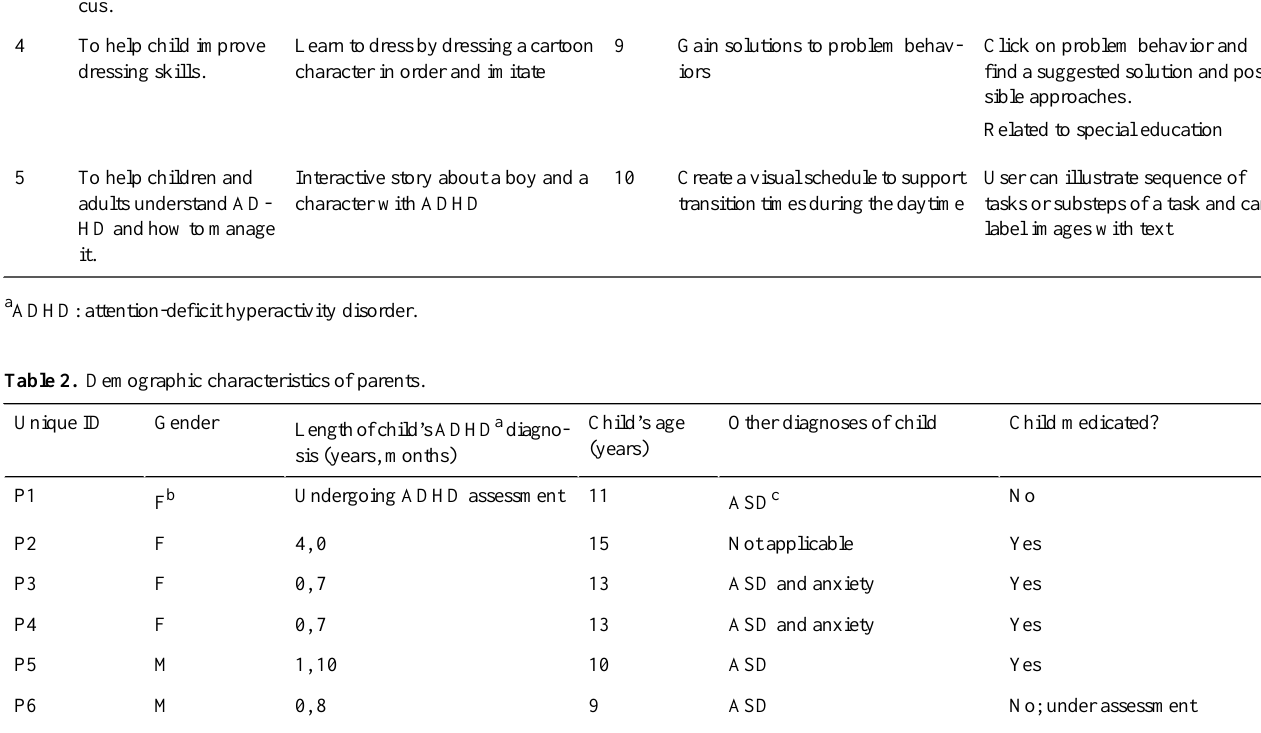
researchNews updates and re- search about ADHD a and other conditions.